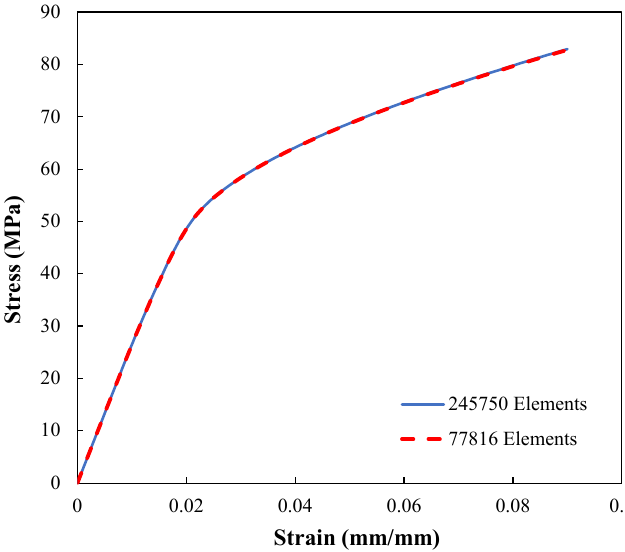
Figure 7. Mesh refinement study of the composite RVE.